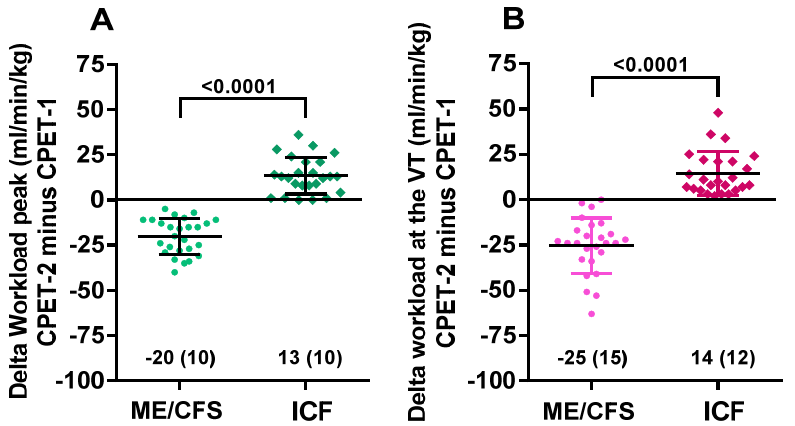
Figure 4. The range of absolute differences for peak workload ( A ) and workload at the ventilatory threshold ( B ) for ME/CFS and ICF patients. Legend Figure 4: CPET: cardiopulmonary exercise test; ME/CFS: myalgic encephalomyelitis/chronic fatigue syndrome; ICF: idiopathic chronic fatigue; VT: ventilatory threshold.